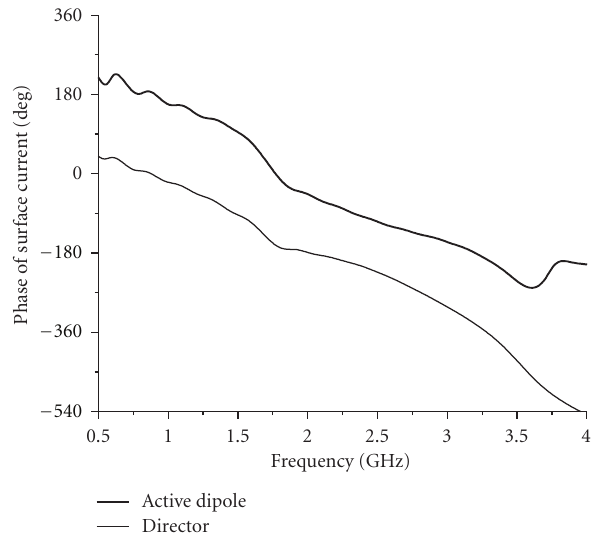
Figure 2: Simulated results of current amplitude at the middle of both the director and active dipole.